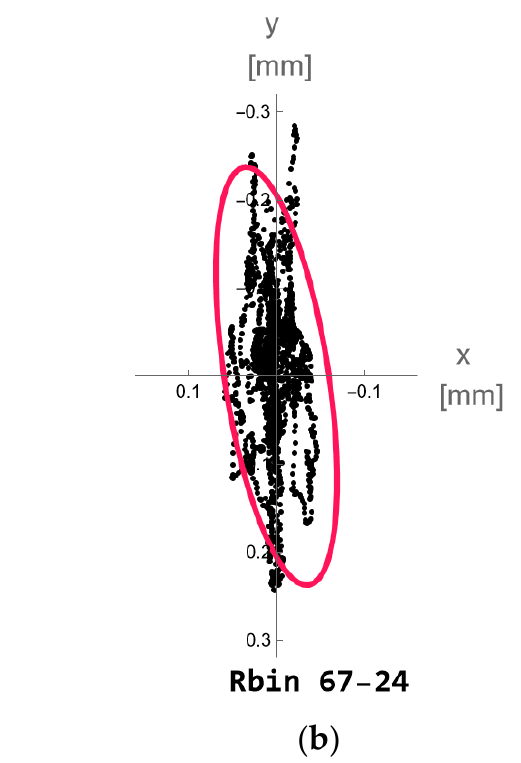
Figure 25. Comparison of total displacements biases between radar and accelerometer measurement with the confidence ellipses (15). Overlay of point clusters (black points) by 95% confidence ellipses (red curves): ( a ) percentage of points in the ellipse that represents accuracy of the displacement vector in R1 Rbin 54 is 98.8%; ( b ) for R1 Rbin 67, the percentage is 95.1%. Figure 26 shows the effect of the quasi static components on the total displacement.